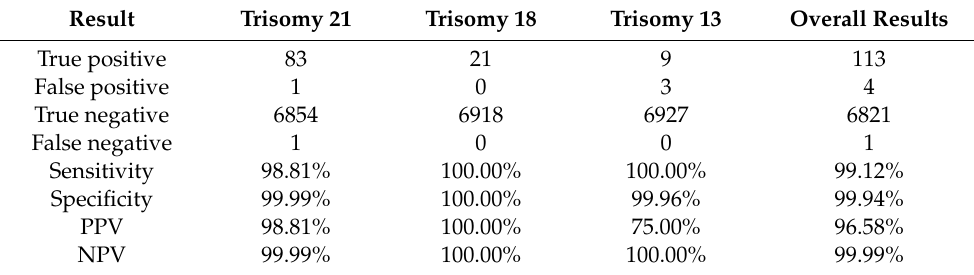
Table 1. Statistics of detection of chromosome 21, 18, and 13 trisomies. PPV—positive predictive value, NPV—negative predictive value, FPR—false positive rate.